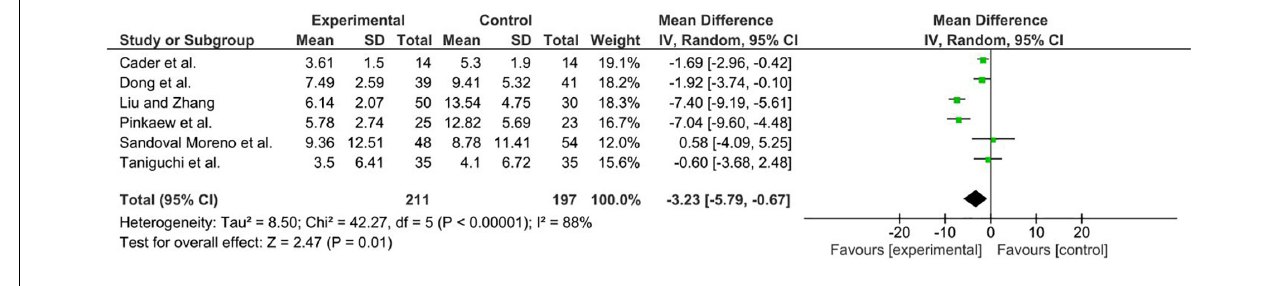
FIGURE 2 | Results of our meta-analysis. TABLE 2 | Quality assessment of the studies included in the present systematic review according to the PEDro scale. Articles Criteria for the quality scoring Score Quality